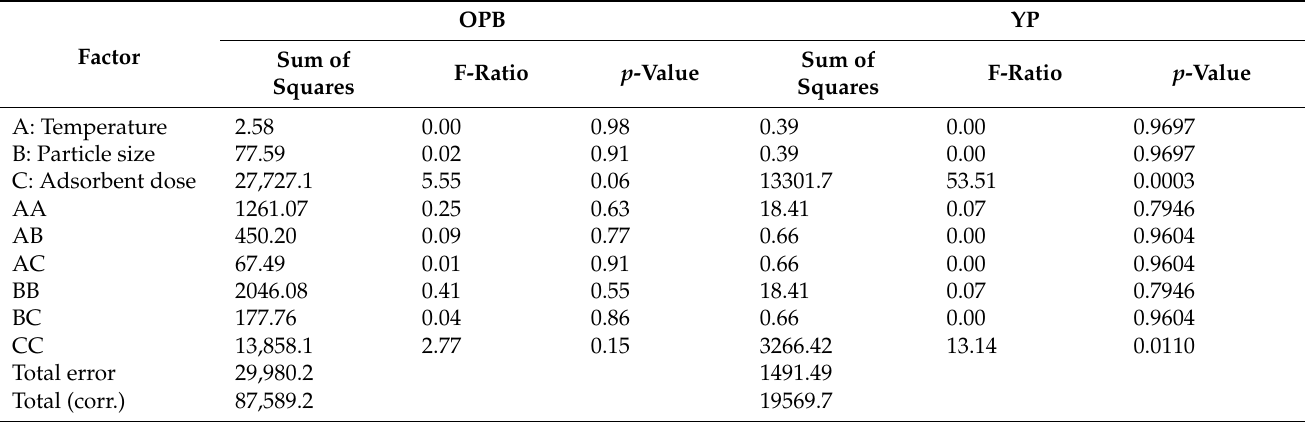
Table 5. Variance analysis for Cr (VI) adsorption capacity onto OPB and